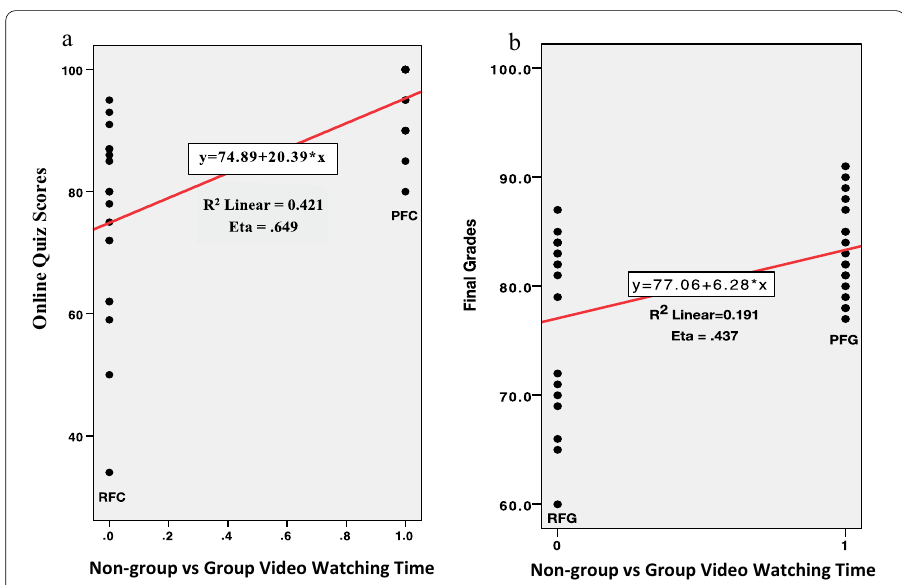
Fig. 3 a Eta-correlation—total online log-on time and online quiz score. b Eta-correlation—total online log-on time and final